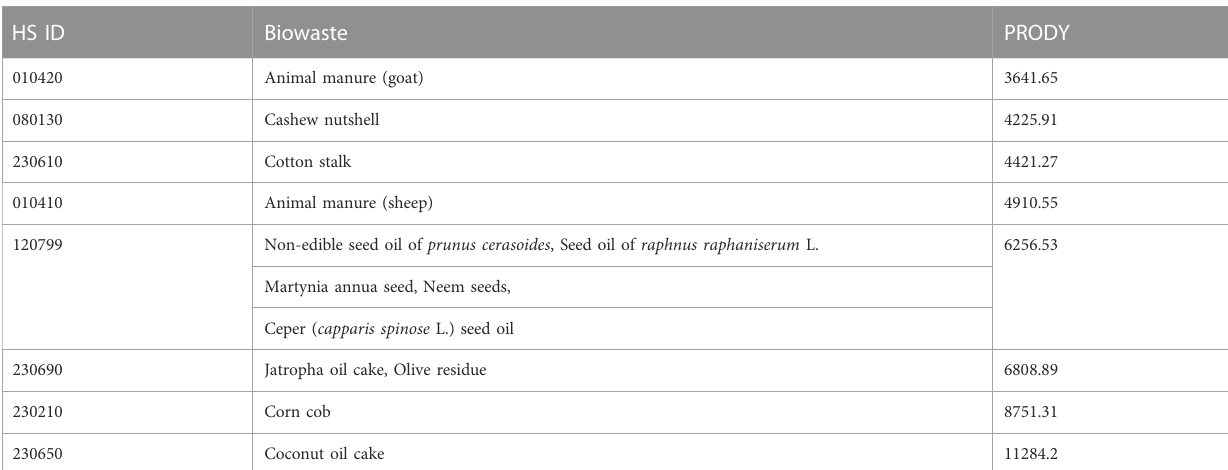
TABLE 1 Low-Income Potential (LIP).